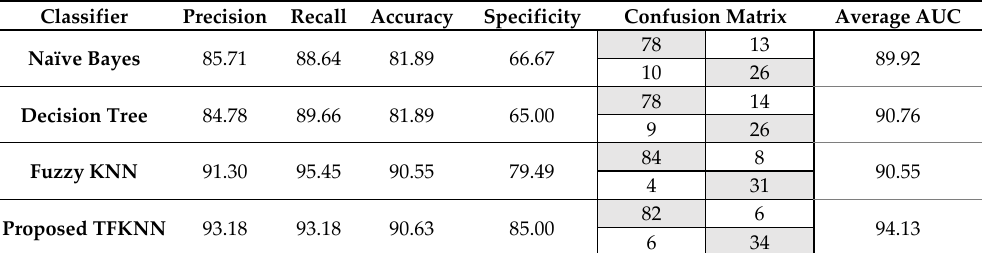
Table 9. Evaluation analysis of the results (best results in bold).